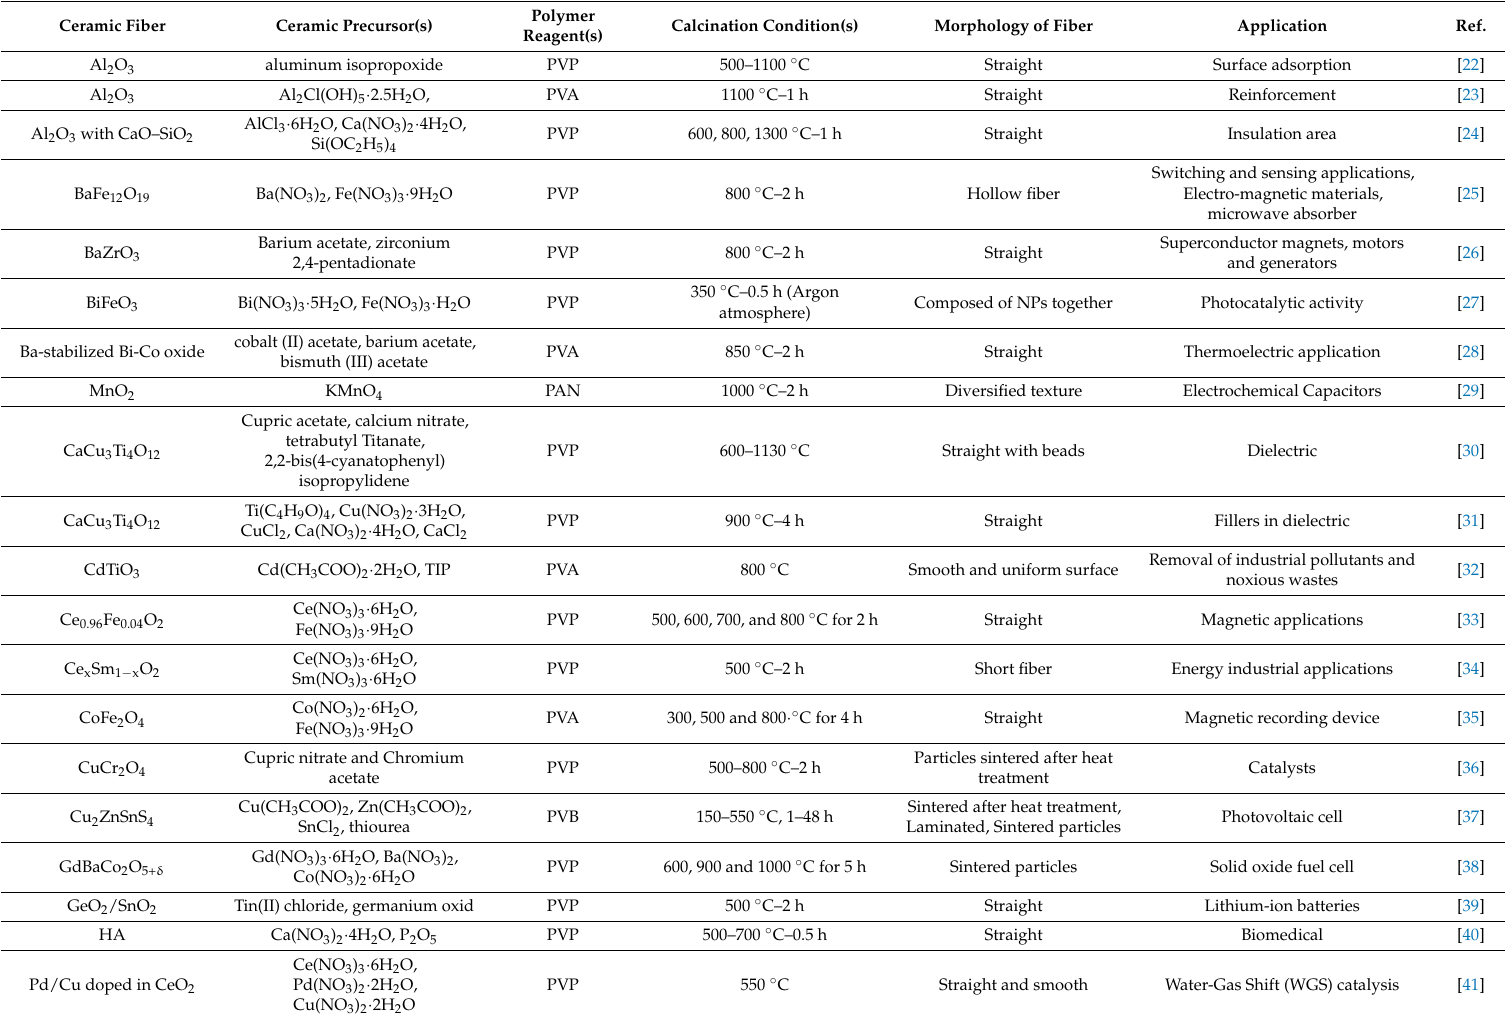
Table 1. Recent developments in single phase electrospun ceramic